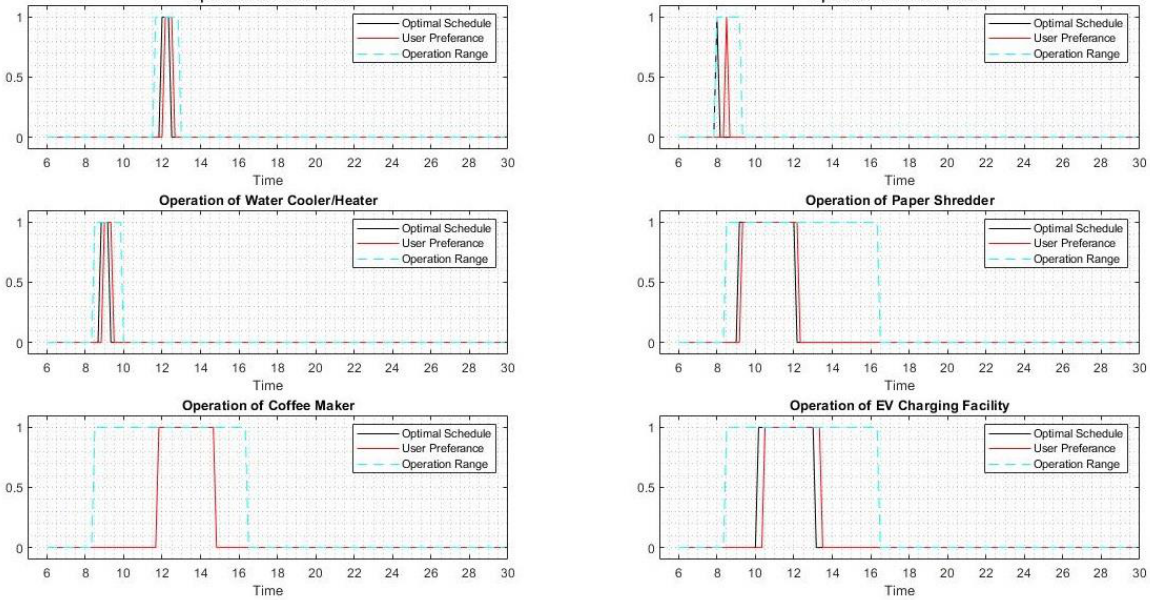
Figure 5. The operation of some assets in one of the office buildings in the case where they did not collaborate.